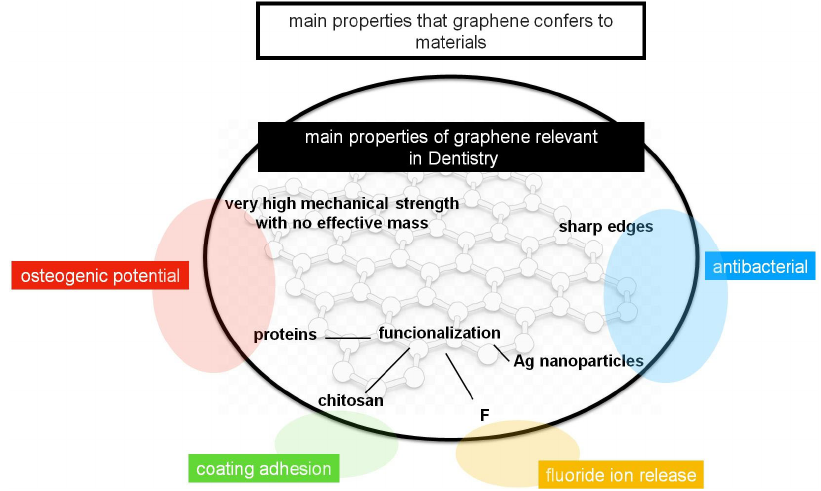
Figure 3. Main properties of the graphene ‐ based materials that are relevant in dentistry (inside circle), and the main properties that they confer to the materials that are commonly used in dentistry (outside